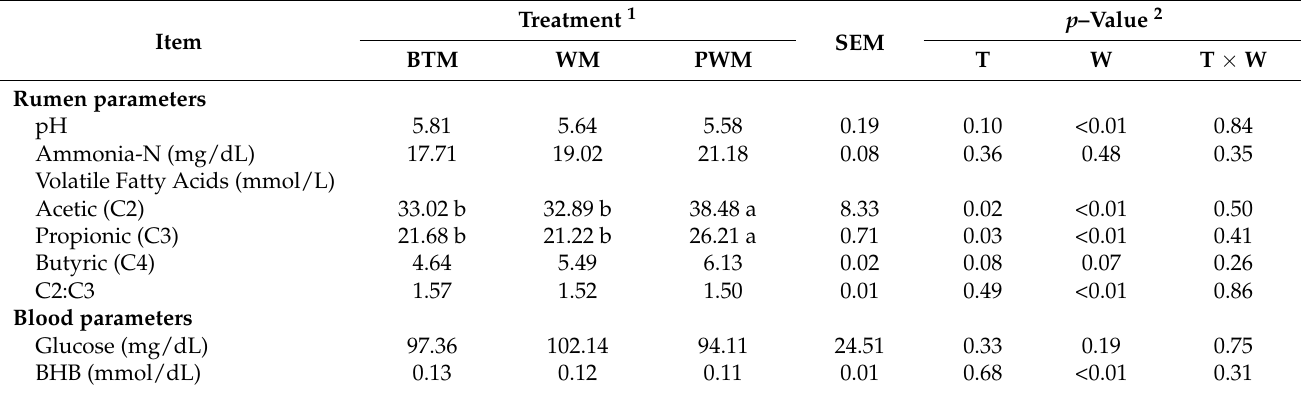
Table 3. Ruminal and blood parameters of dairy calves fed bulk tank milk (BTM, n = 15), waste milk (WM, n = 15), and pasteurized waste milk (PWM, n = 15) during 4–60 d of age.